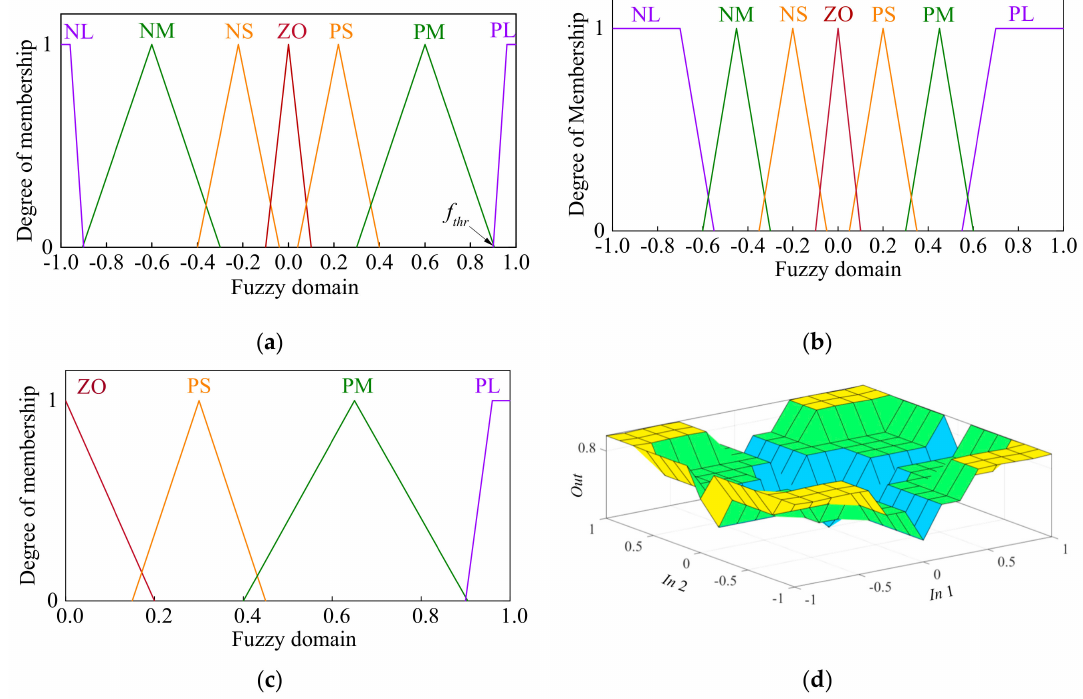
Figure 9. Fuzzy membership functions. ( a ) Frequency deviation; ( b ) Power disturbance; ( c ) Output damping correction; ( d ) Relationship between inputs and output in the form of surface view. (d)